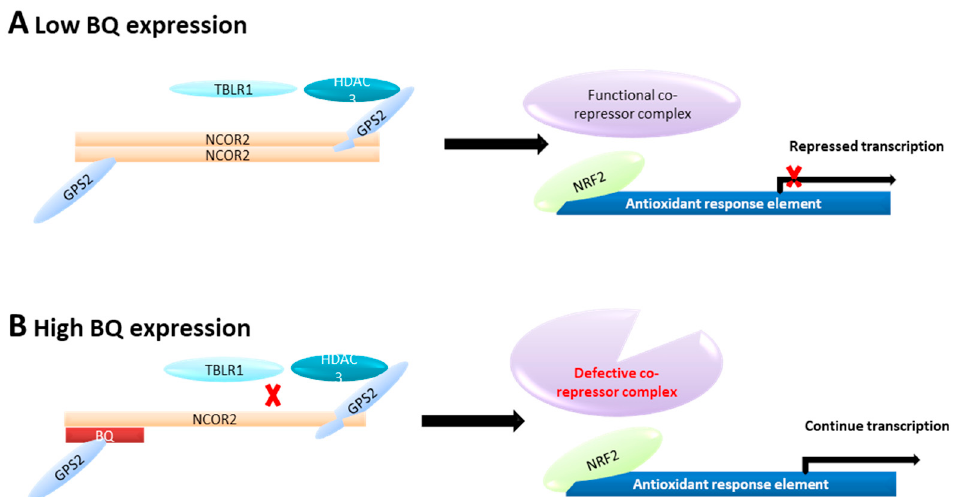
Figure 8. Proposed mechanism of how BQ may contribute to chemoresistance via the regulation of NRF2 in breast cancer. ( A ) Without BQ expression, NCOR2 self-dimerizes in antiparallel fashion, forming a central platform to recruit other corepressor components, such as GPS2, TBL1, and HDACs, to form a functional NCOR2 corepressor complex. The NCOR2 corepressor complex interacts with NRF2 to suppress the transcriptional activity of ARE which is used to regulate the expression of antioxidant genes. ( B ) In the presence of BQ nuclear overexpression, BQ binds with NCOR2This interaction compromises the ability of NCOR2 to fully recruit other corepressor components such as HDACs. This gives rise to a non-fully functional NCOR2 corepressor complex, thus relieving the suppressive effect on NRF2. Upregulation of ARE mediated transcription of antioxidant genes is resulted.